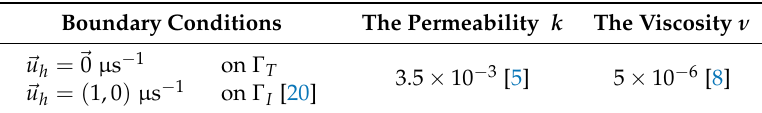
Table 1. Boundary conditions and parameters